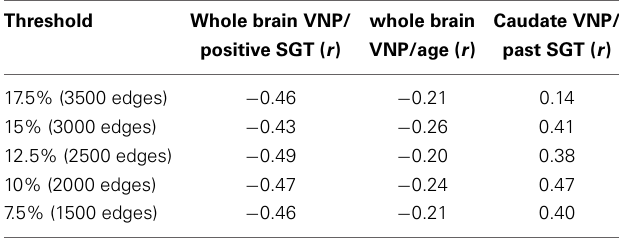
Table 2 | Impact of different initial graph thresholds for the main results of the